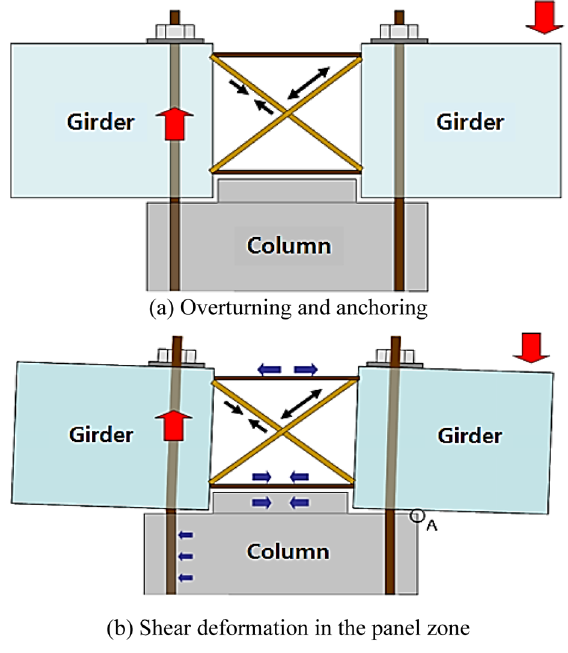
Fig. 15. Stress mechanisms due to overturning and shear deformation